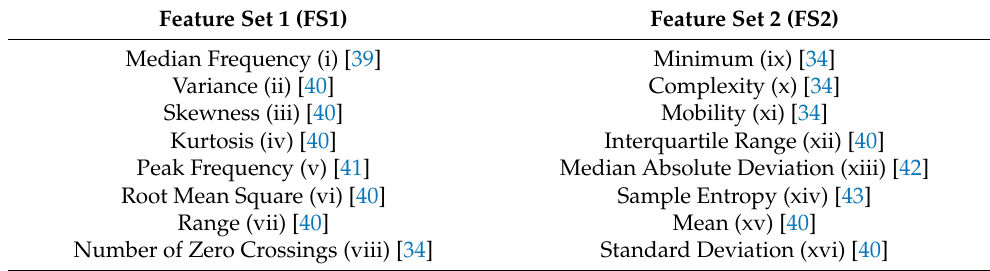
Table 1. Features’